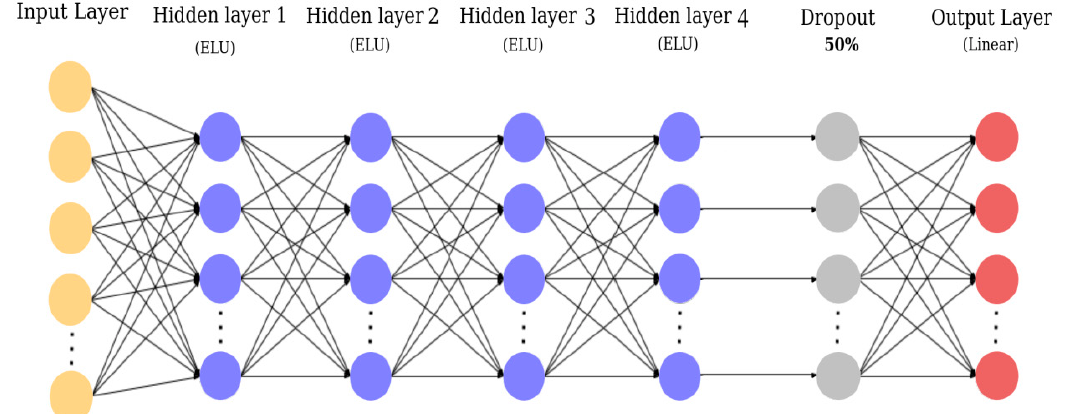
Figure 6. Proposed fully-connected deep neural networks (FCDNN) with multiple hidden layers and a dropout layer.